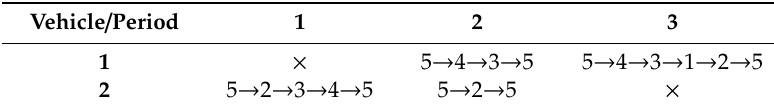
Table 11. Vehicle